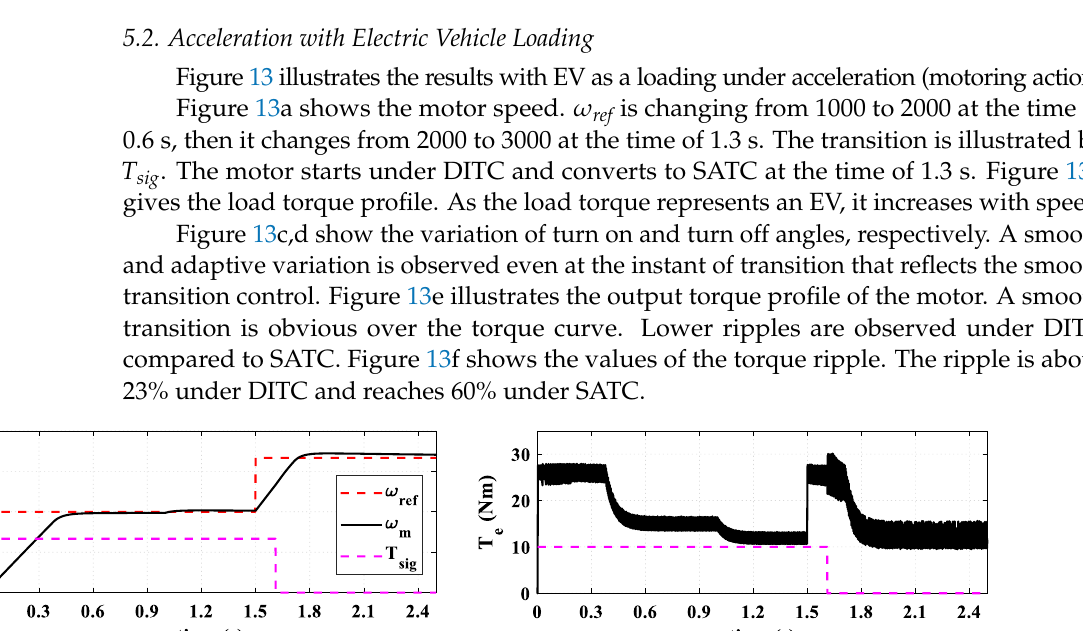
Figure 11. The optimized θ off angles: ( a ) DITC, ( b ) ATC.